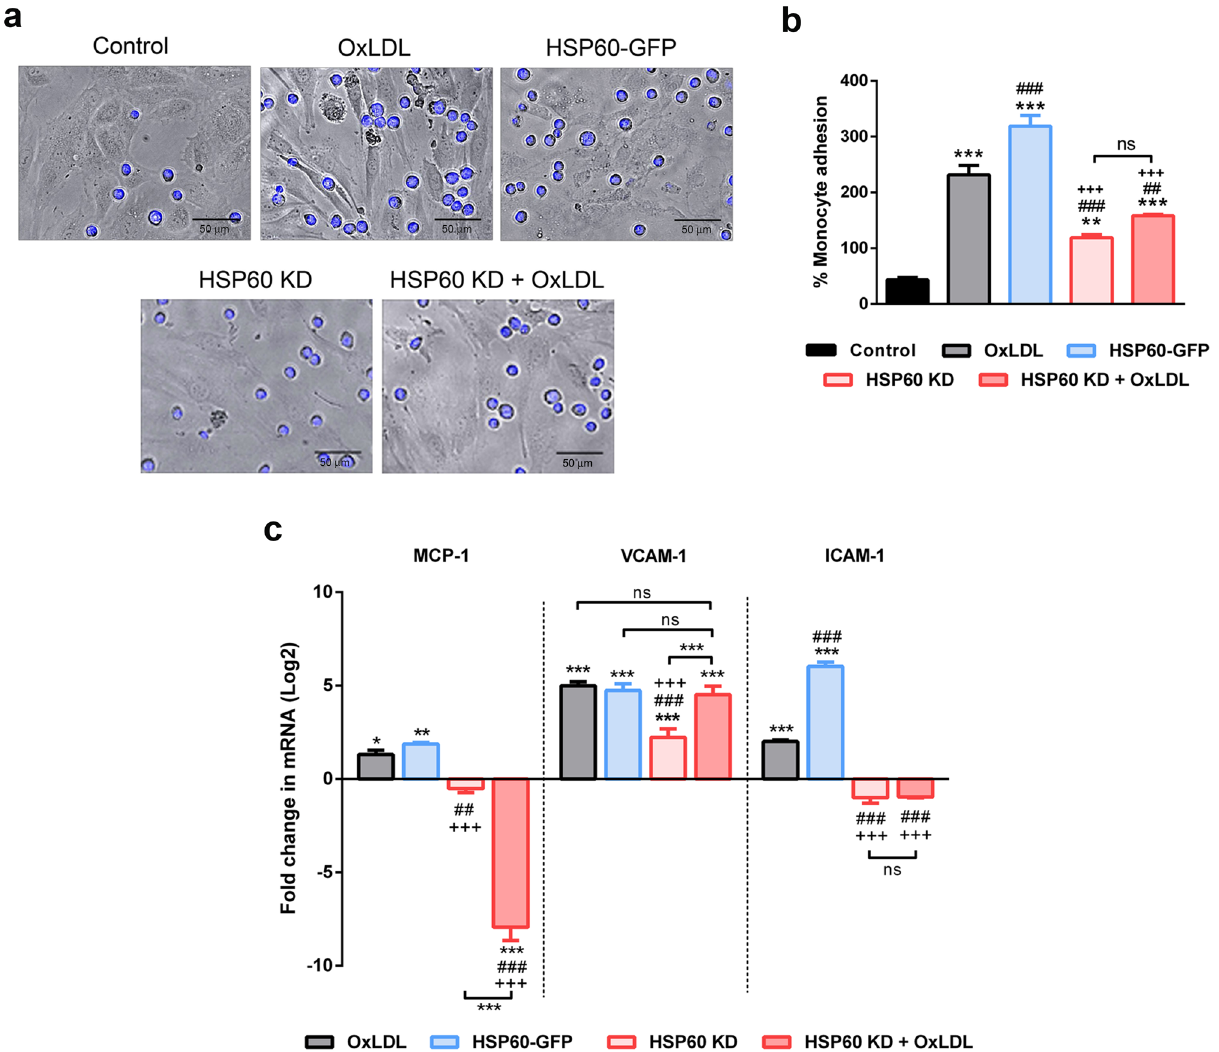
Figure 6. HSP60 mediated endothelial activation in HUVEC. The adhesion of THP-1 cells to HUVEC subjected to various experimental conditions was assessed by ( a ) microscopic analysis and ( b ) the % monocyte adhesion was calculated relative to number of HUVECs (n = 5). Scale bar = 50 µm. **p < 0.01, ***p < 0.001 vs untreated control, ## p < 0.01, ### p < 0.001 vs OxLDL, and +++ p < 0.001 vs HSP60-GFP, One way-ANOVA followed by Tukey’s multiple comparison test. ( c ) mRNA of MCP-1, VCAM-1 and ICAM-1 was assessed by quantitative RT-PCR (n = 3). Data were expressed as Mean ± SEM. *p < 0.05, **p < 0.01, ***p < 0.001 vs untreated control, ## p < 0.01, ### p < 0.001 vs OxLDL, and +++ p < 0.001 vs HSP60-GFP, Two way-ANOVA followed by Tukey’s multiple comparison